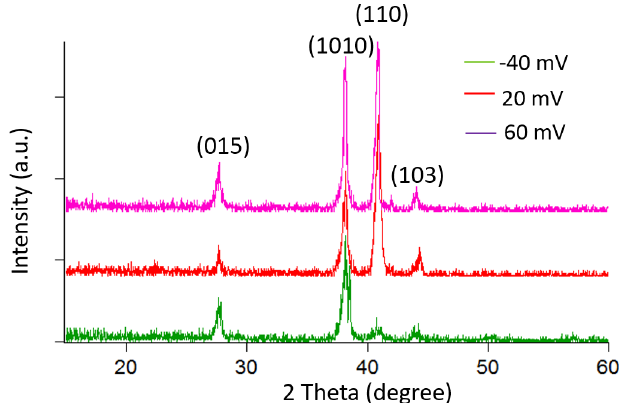
Figure 5. X-ray diffraction ( XRD) pattern of the BiTe films for different deposited potentials.